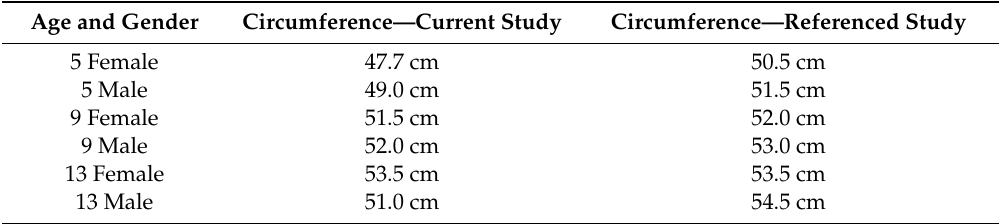
Table 6. Comparison of head circumference of current study to report by Rollins, et al. [28] reference